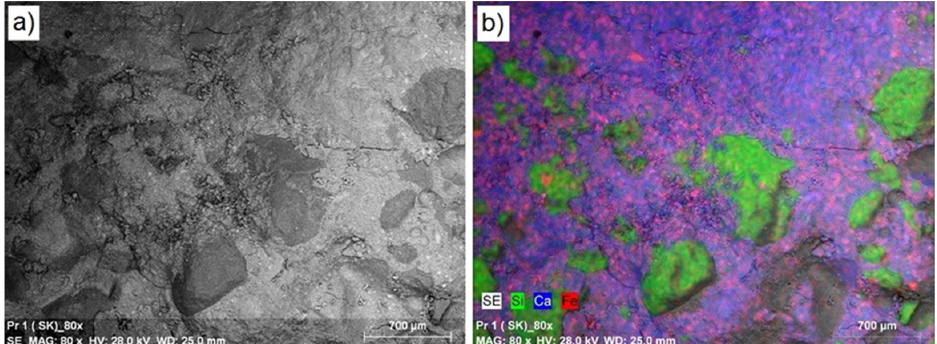
Figure 4. Control concrete microstructure: ( a ) 80 times magnification; ( b ) a map of the location of dominant elements [9].